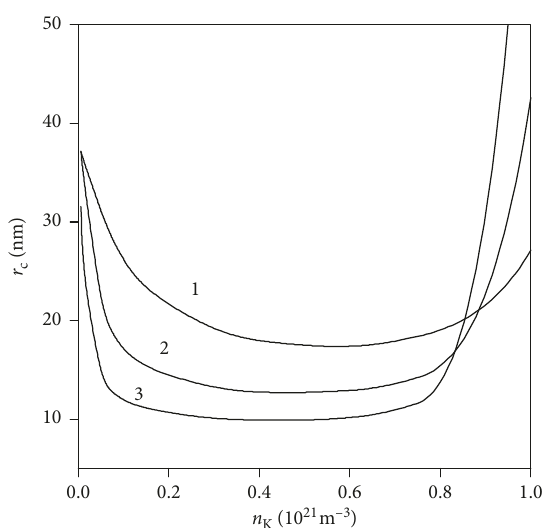
Figure 6: Dependence of the particle radius of Al concentration of potassium atoms at different temperatures.